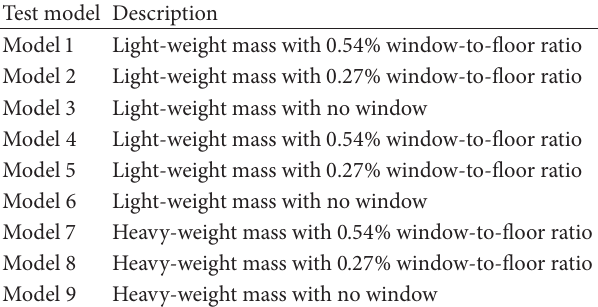
Table 2: Description of